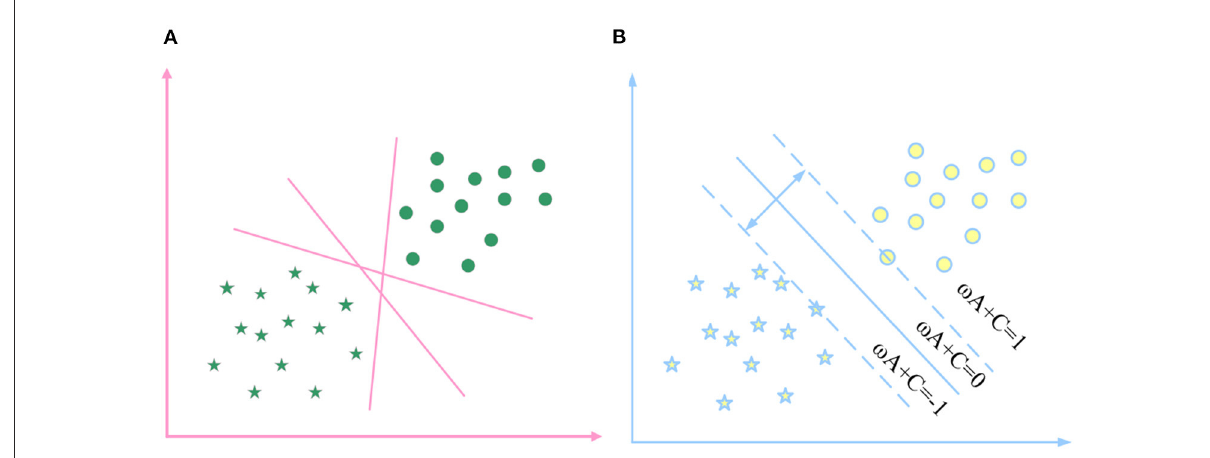
FIGURE3 The optimal classification hyperplane in the linearly separable case.